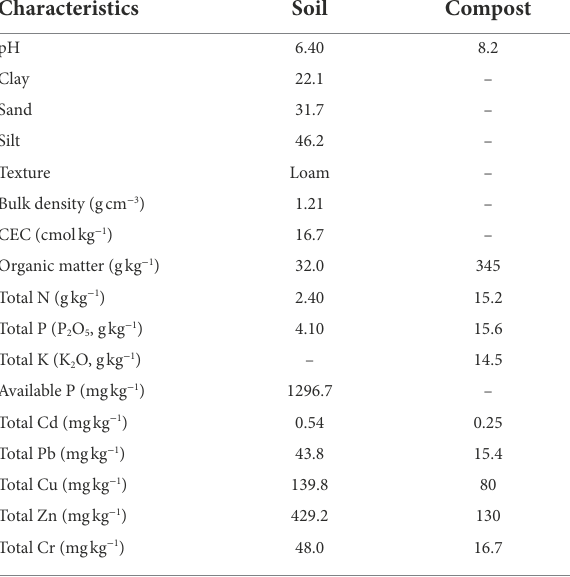
TABLE 1 Basic properties of the tested soil and